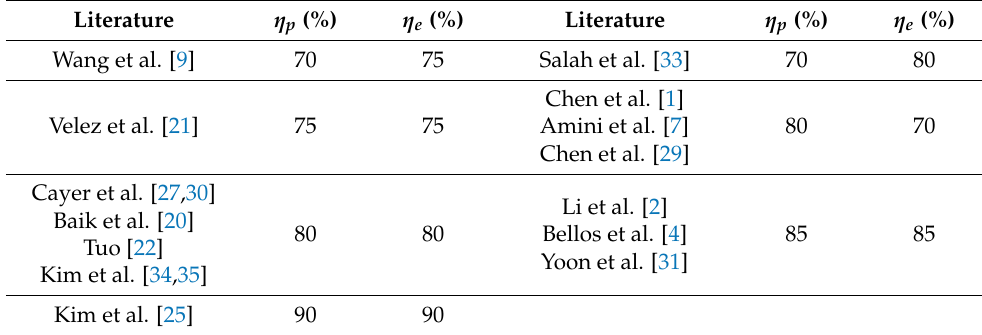
Table 1. Commonly assumed values of η p and η e in